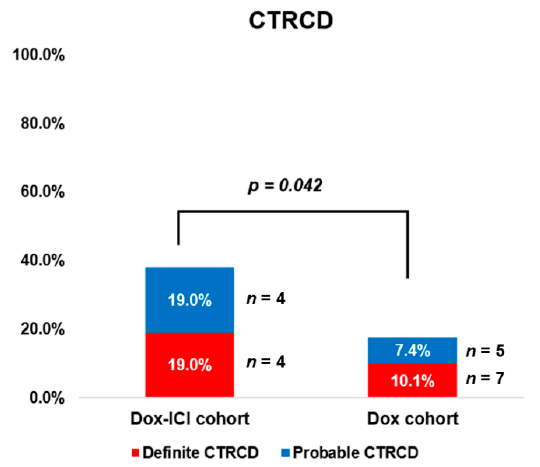
Figure 3. Higher incidence of CTRCD in the Dox-ICI cohort than in the Dox cohort.